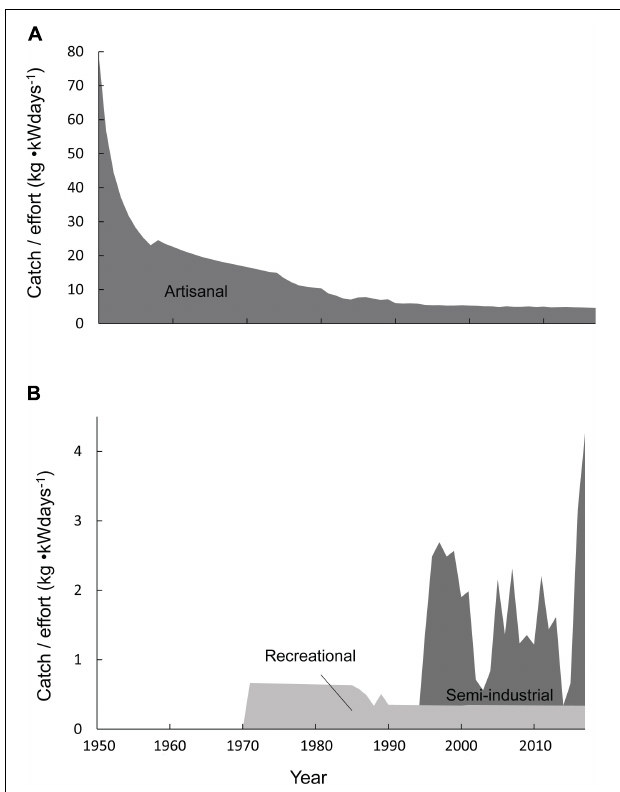
FIGURE 5 | Catch-per-unit-effort (CPUE) for the domestic fisheries in the Seychelles from 1950 to 2017, for (A) artisanal; and (B) recreational sportfishing and semi-industrial